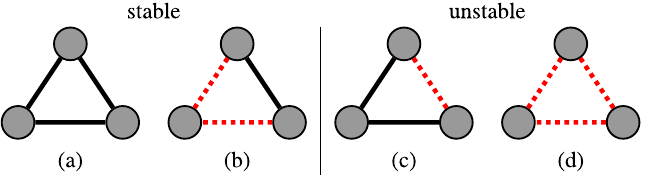
Figure 2. According to the structural balance theory, ( a , b ) are stable triadic motifs, while ( c , d ) are unstable. Solid black lines ( ) indicate positive links, while the negative links are indicated by dotted red lines (